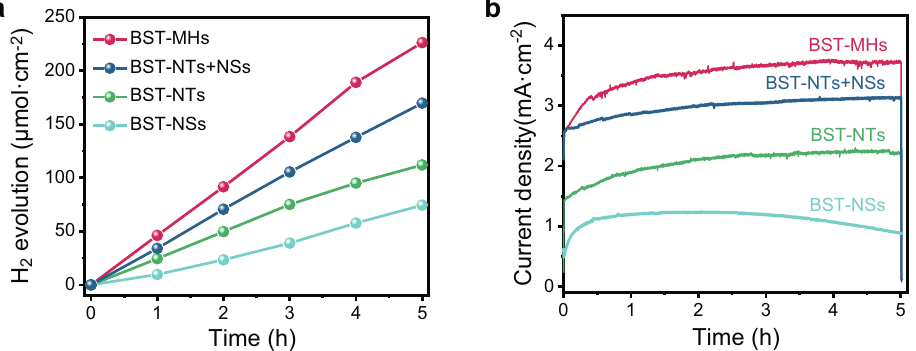
Fig. 4 PEC H 2 evolution. a , b H 2 evolution ( a ) and photocurrent densities ( b ), of the BST-MH, BST-NT, BST-NS, and BST-NT + BST-NS photoanodes at 0.6 V RHE . The experiments were measured in an electrolyte solution containing 0.08 mol L − 1 Na 2 S and 0.50 mol L − 1 Na 2 SO 3 as hole scavengers (pH = 12.9) under NIR light irradiation ( λ > 800 nm, 100 mW cm − 2